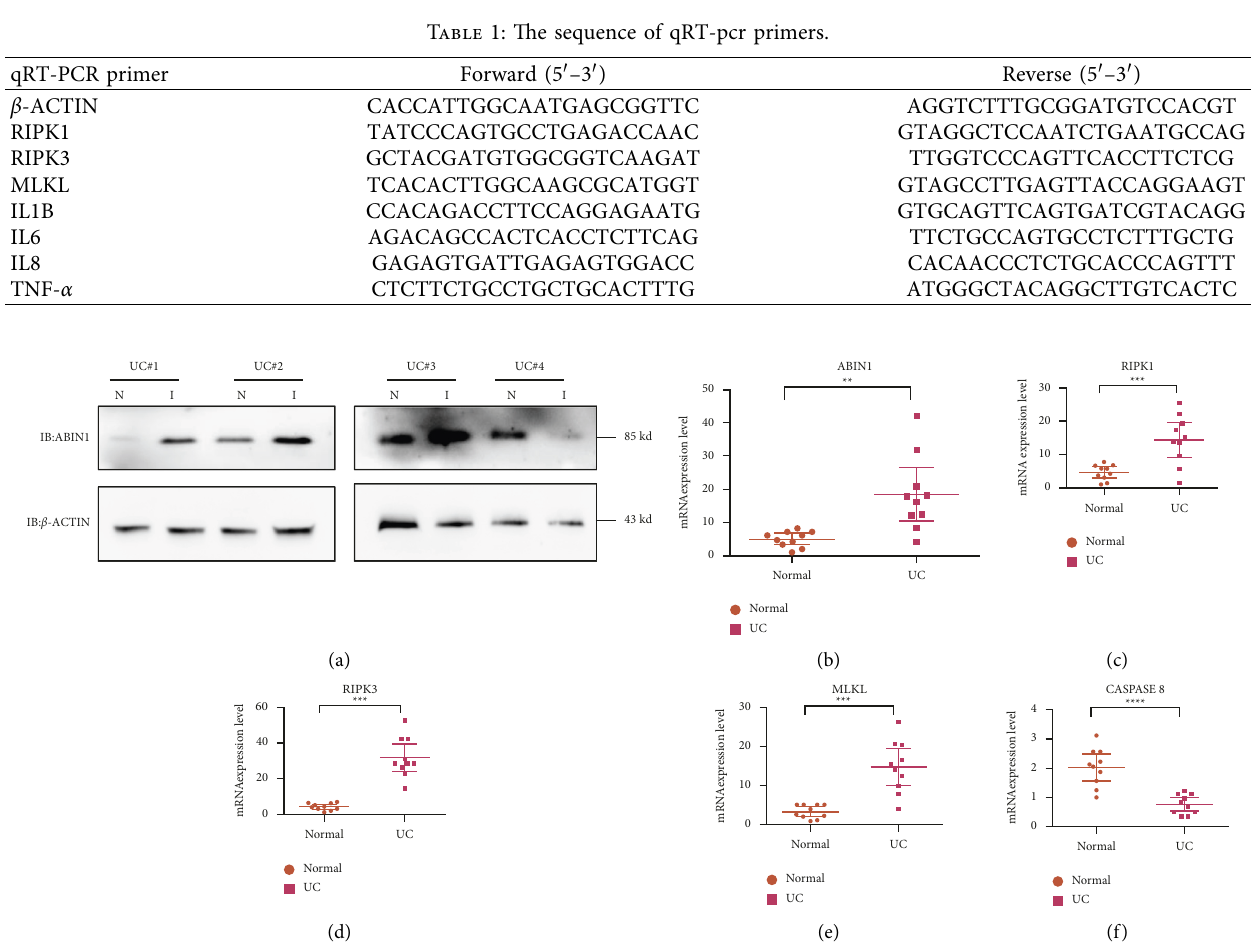
Figure 1: ABIN1 is markedly increased in the UC samples. (a) ABIN1 protein expression level was assessed in 4 pairs of UC patients; (b)–(f) the mRNA expression level of ABIN1, RIPK1, RIPK3, MLKL, and CASPASE8 were detected in ten pairs of UC patients’ mucosal and adjacent normal tissues. Two-tailed student’s t -test was performed to assess statistical significance ∗∗ P < 0 . 01, ∗∗∗ P < 0 .